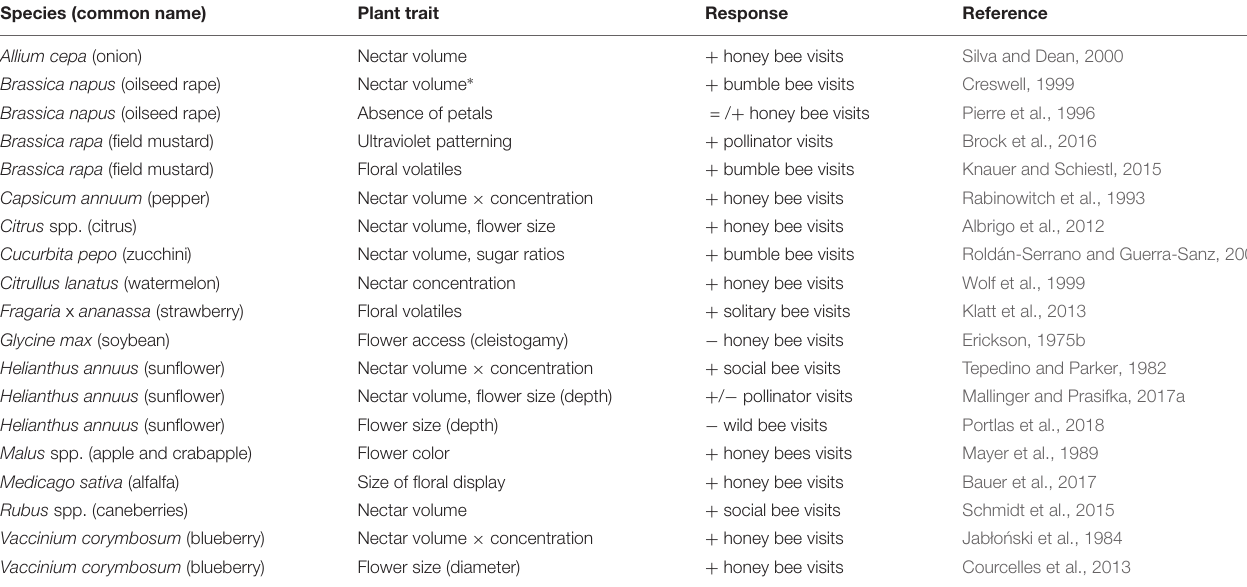
TABLE 1 | Nectar-related traits and pollinator responses for selected crops and crop wild